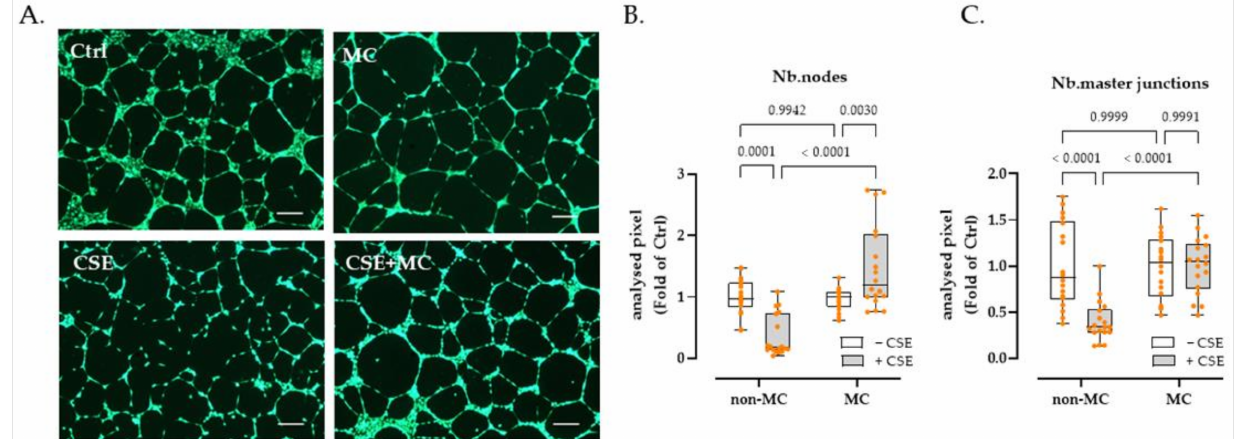
Figure 2. HUVEC cells were used as an indicator to examine changes in the angiogenic capacity of HaCaT cell supernatants after CSE or MC stimulation. ( A ) Representative fluorescent Calcein-AM (2 µ M, green) staining showing the effect of HaCaT supernatant collected from different groups on HUVEC tube formation. ( B , C ) showed that 3% CSE significantly decreased Nb.nodes (63.82% decline, as x-fold of Ctrl) and Nb.master junction (60.36% decline, as x-fold of Ctrl); 100 µ A MC increased the above indices by 396.85% and 154.29% in CSE-injured HaCaT cells; however, no significant improvement of MC was observed in the tube-forming ability of control HaCaT cells. Scales bars indicate 200 µ m in length. N = 6, n = 3. Non-parametric two-way ANOVA followed by Tukey’s multiple comparisons was performed to compare the